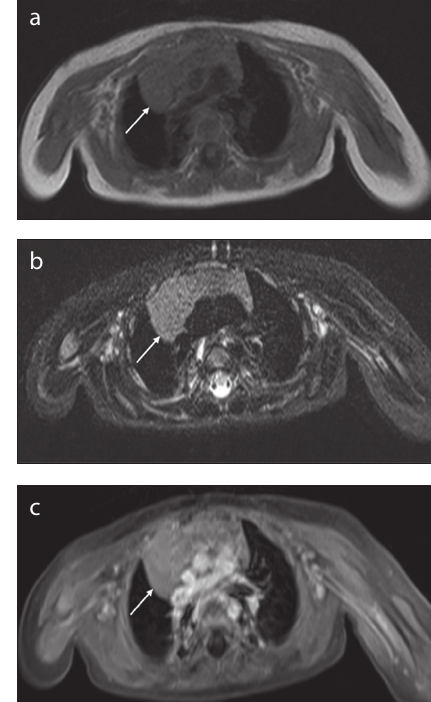
Figure 6. a-c. An 11-year-old male with pathologically confirmed thymoma in the anterior mediastinum. Axial T1-weighted image (a) reveals hypointense thymoma lesion (white arrow). Axial T2-weighted image (b) reveals hyperintense thymoma lesion (white arrow). Axial postcontrast-enhanced T1-weighted image (c) reveals no contrast enhancement in the thymoma lesion (white arrow).